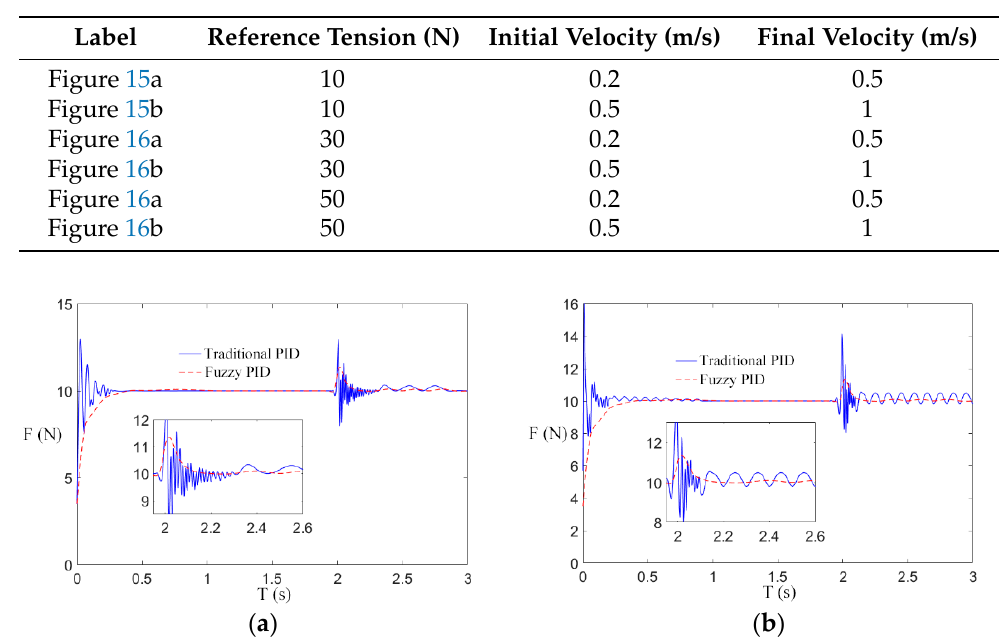
Figure 18. Six situations of tension fluctuation. Combined with engineering practice, the transformer winding machine in the pro- cess of winding will adopt different process parameters and use a different number of guide rollers; therefore, this paper studies the response effect of the system to tension when the number of guide rollers varies. As shown in Figure 19, the tension response curves of guide rollers with different numbers are simulated by increasing the load mass. ( a ) ( b ) Figure 19. Tension response of the different number of guide rollers. ( a ) Situation 1; ( b ) Situation 2.